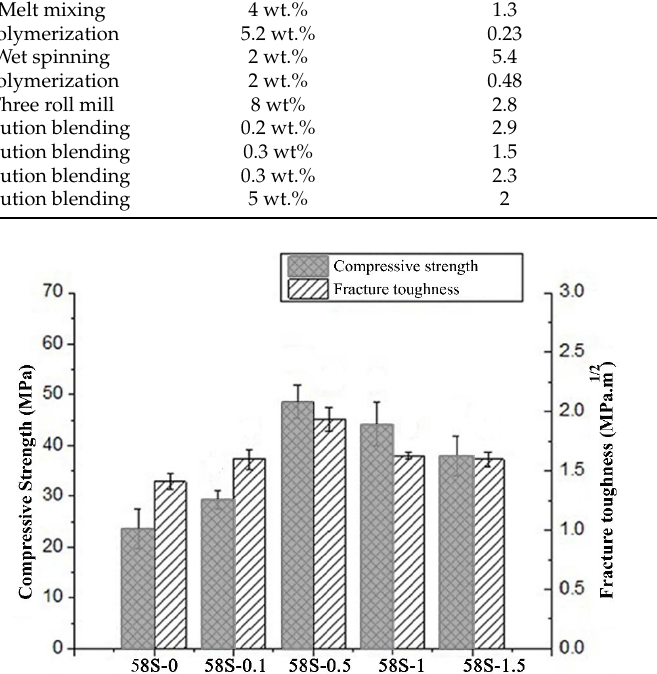
Figure 17. Mechanical properties of graphene nanocomposites. Reproduced from [212] (CC BY).